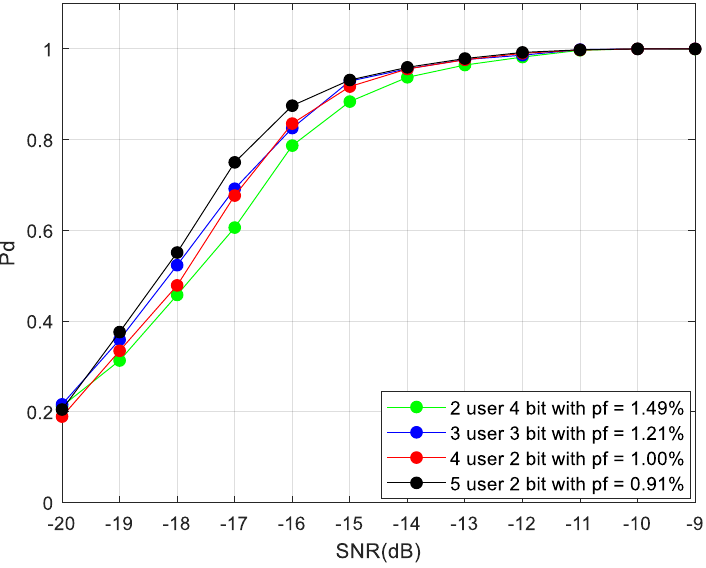
Figure 6. Detection performance of the candidate optimal combination scheme. Where ‘a user b bit’ means the number of cognitive vehicles is ‘a’ and the number of quantified information bits is ’b’.